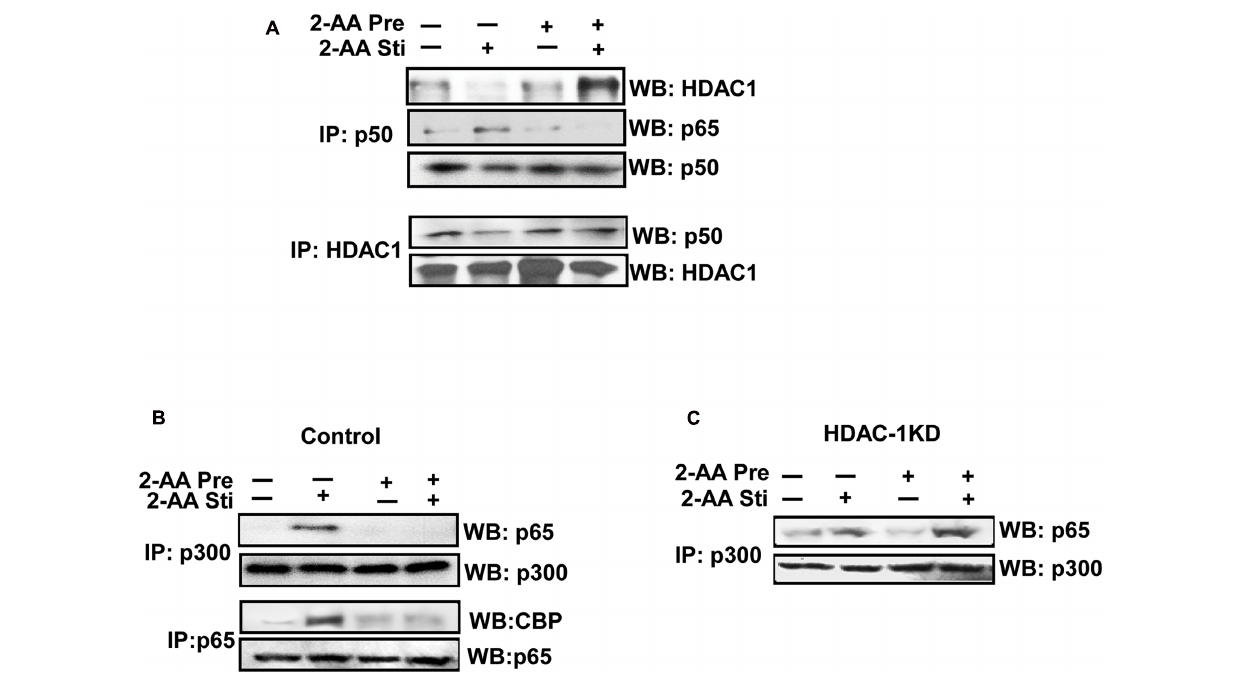
FIGURE 6 | 2-AA tolerization induces interaction between NF- κ B p50 and HDAC1 and disrupts p65-CBP/p300 binding. (A) Co-IP assay showing p50/HDAC1 interaction in 2-AA stimulated and 2-AA-tolerized THP-1 cells following at 1 h 2-AA stimulation (top blot, far right band). (B,C) . Co-IP assay confirming that 2-AA tolerization inhibits the interaction of p65 with CBP and p300 in vector control RAW264.7 cells (B) , and demonstrating an increased interaction of p300-p65 in HDAC1 KD cells (C) following 1 h 2-AA stimulation (1 h). WB, Western blot; Co-IP, co-immunoprecipitation. Data are representative of three independent